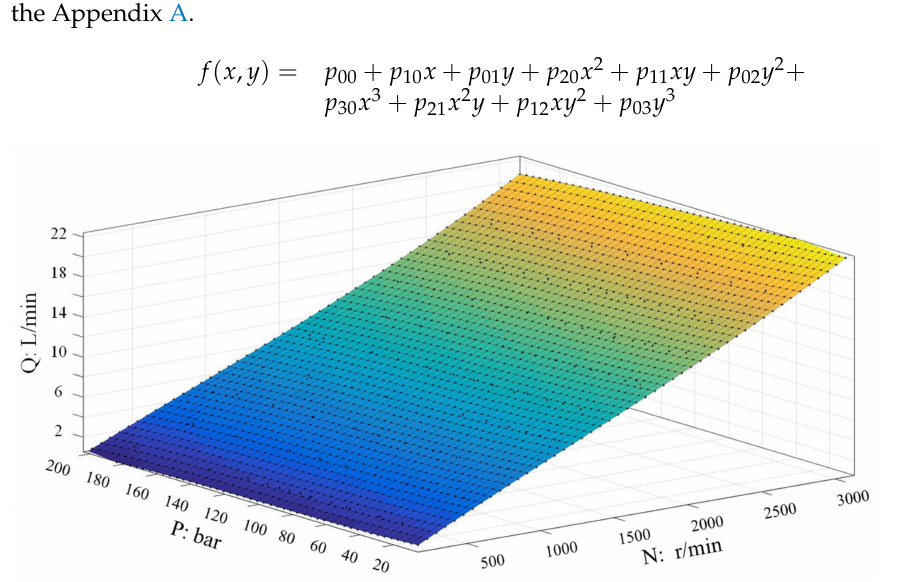
Figure 17. Pump flow mapping.